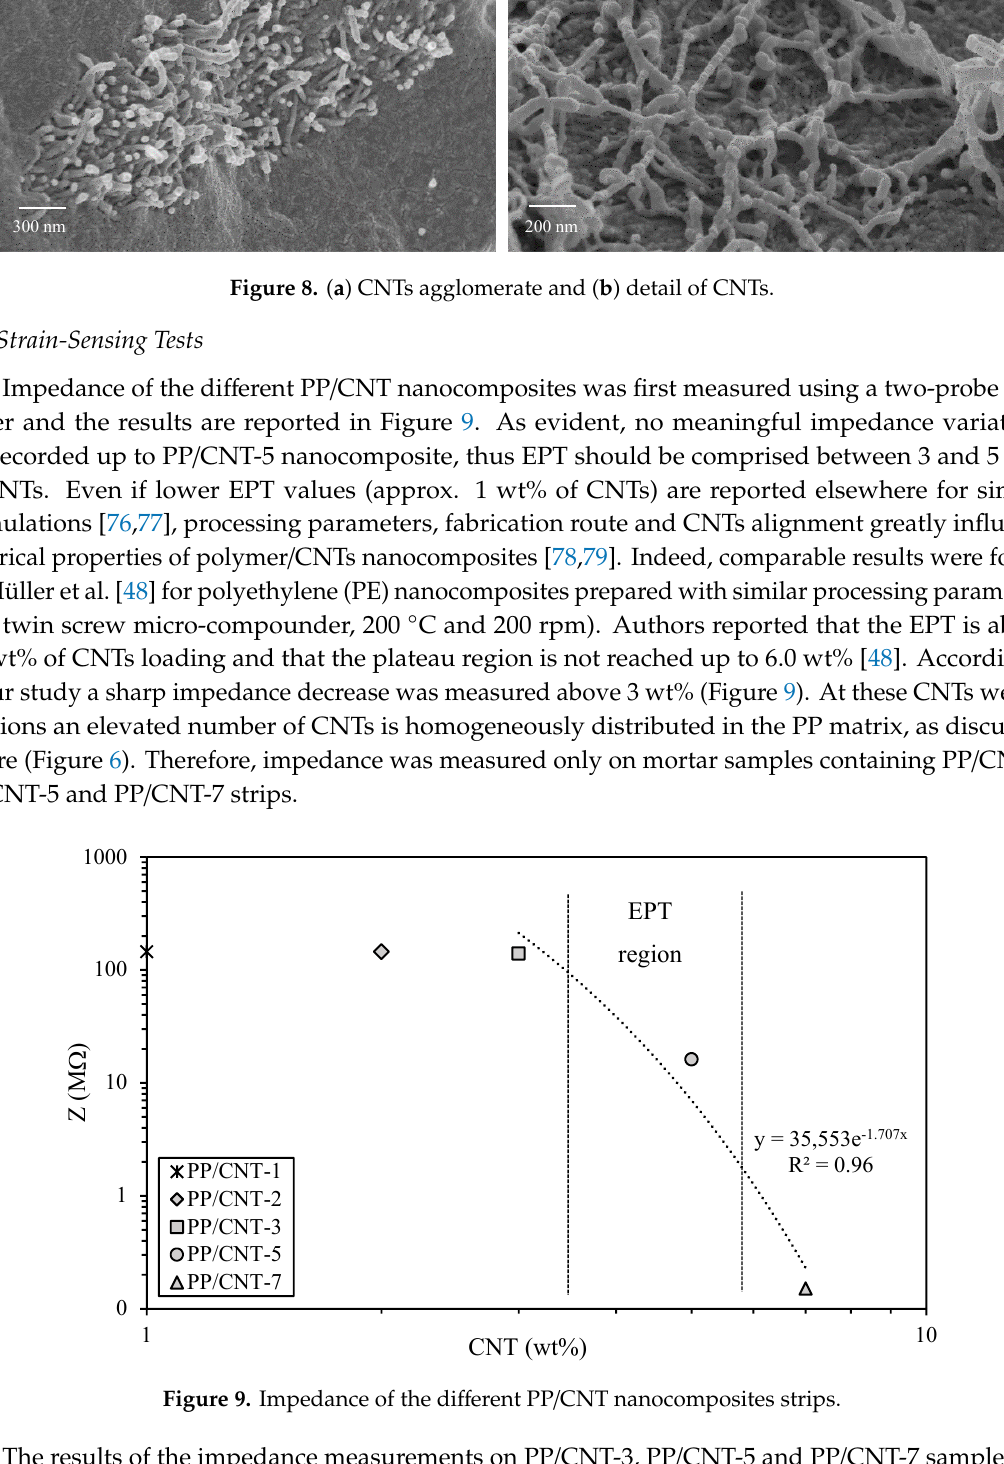
Figure 9: Impedance of the different PP/CNT nanocomposites strips Figure 9. Impedance of the di ff erent PP / CNT nanocomposites